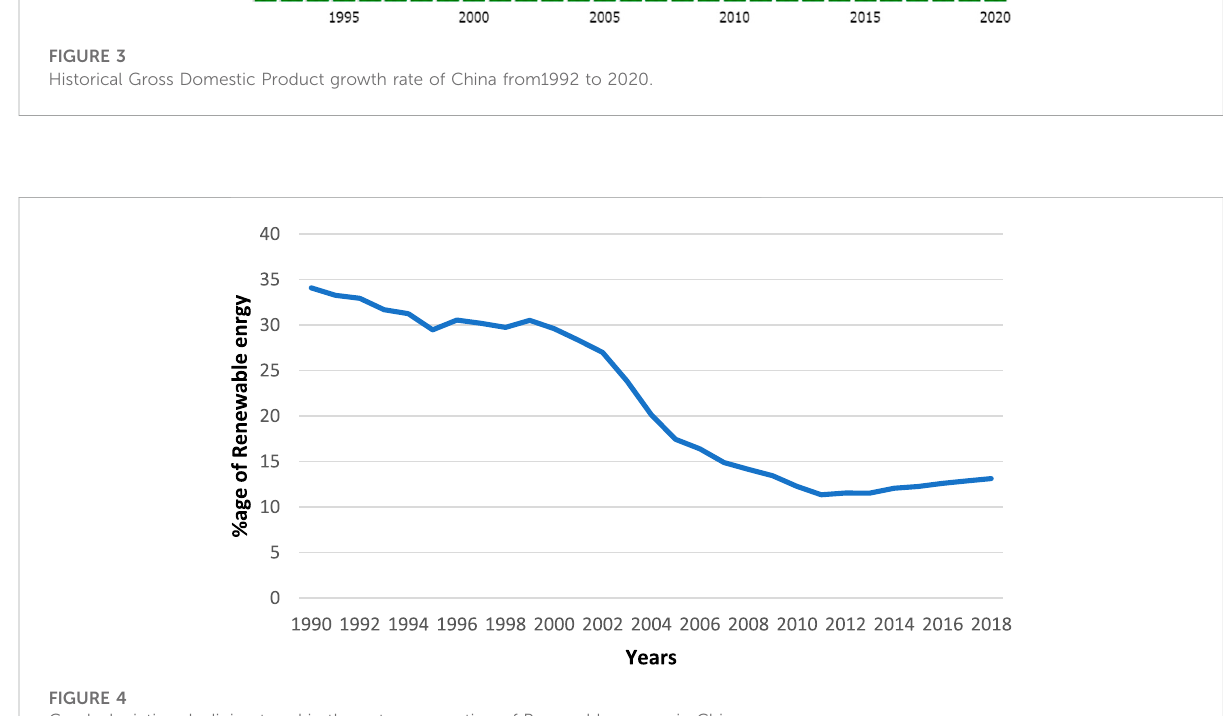
FIGURE 4 Graph depicting declining trend in the net consumption of Renewable energy in